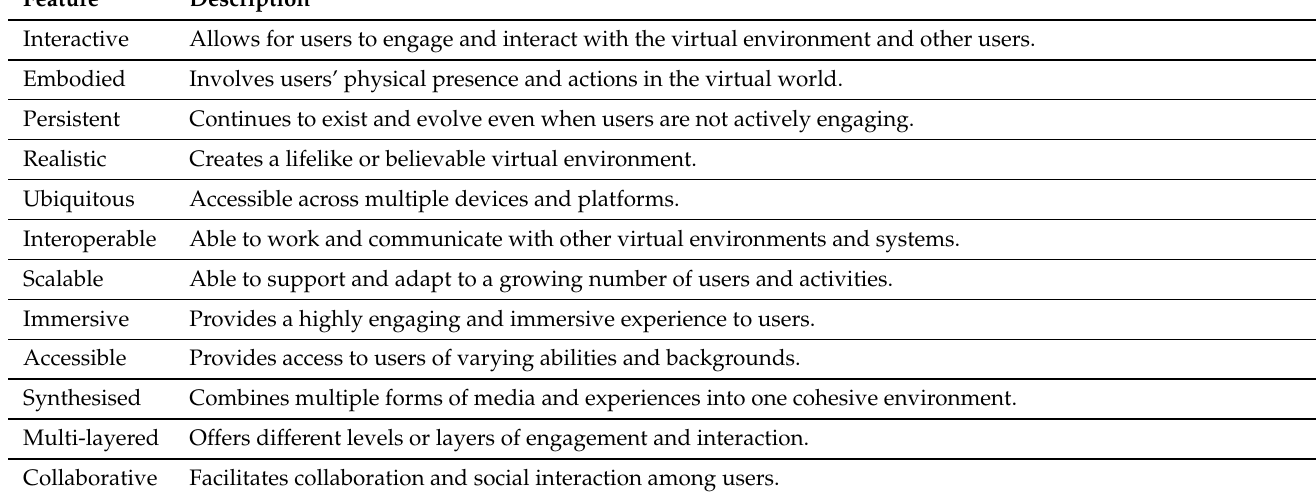
Table 1. A table of key metaverse features based on the literature review, along with a